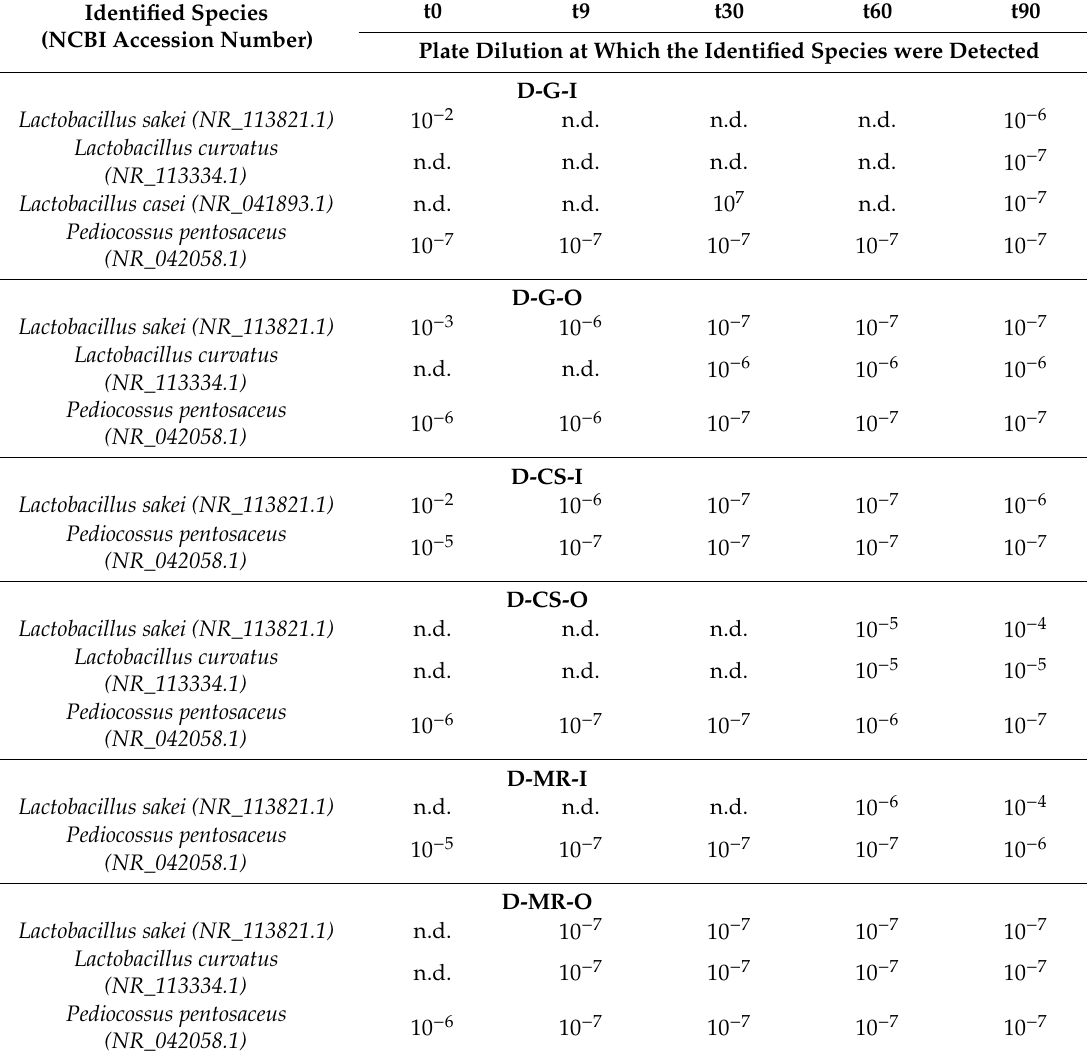
Table 2. Plate dilutions at which each identified species were detected per sampling point from the industrial plant